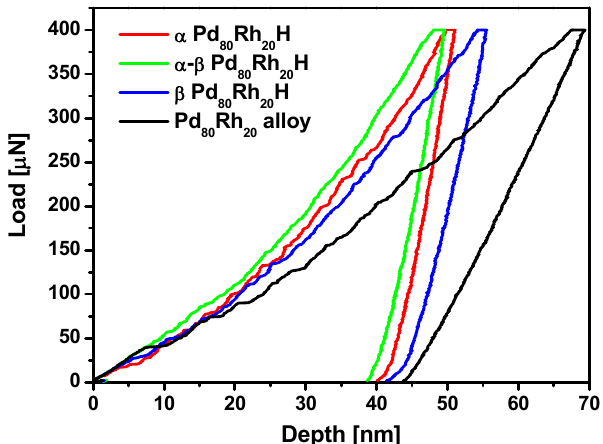
Figure 8. A comparison of representative nanoindentation load-displacement curves for the Pd 80 Rh 20 alloy, α Pd 80 Rh 20 H where H / (Pd + Rh) is 0.002, α - β Pd 80 Rh 20 H where H / (Pd + Rh) is 0.4, and β Pd 80 Rh 20 H where H / (Pd + Rh) is 0.8.